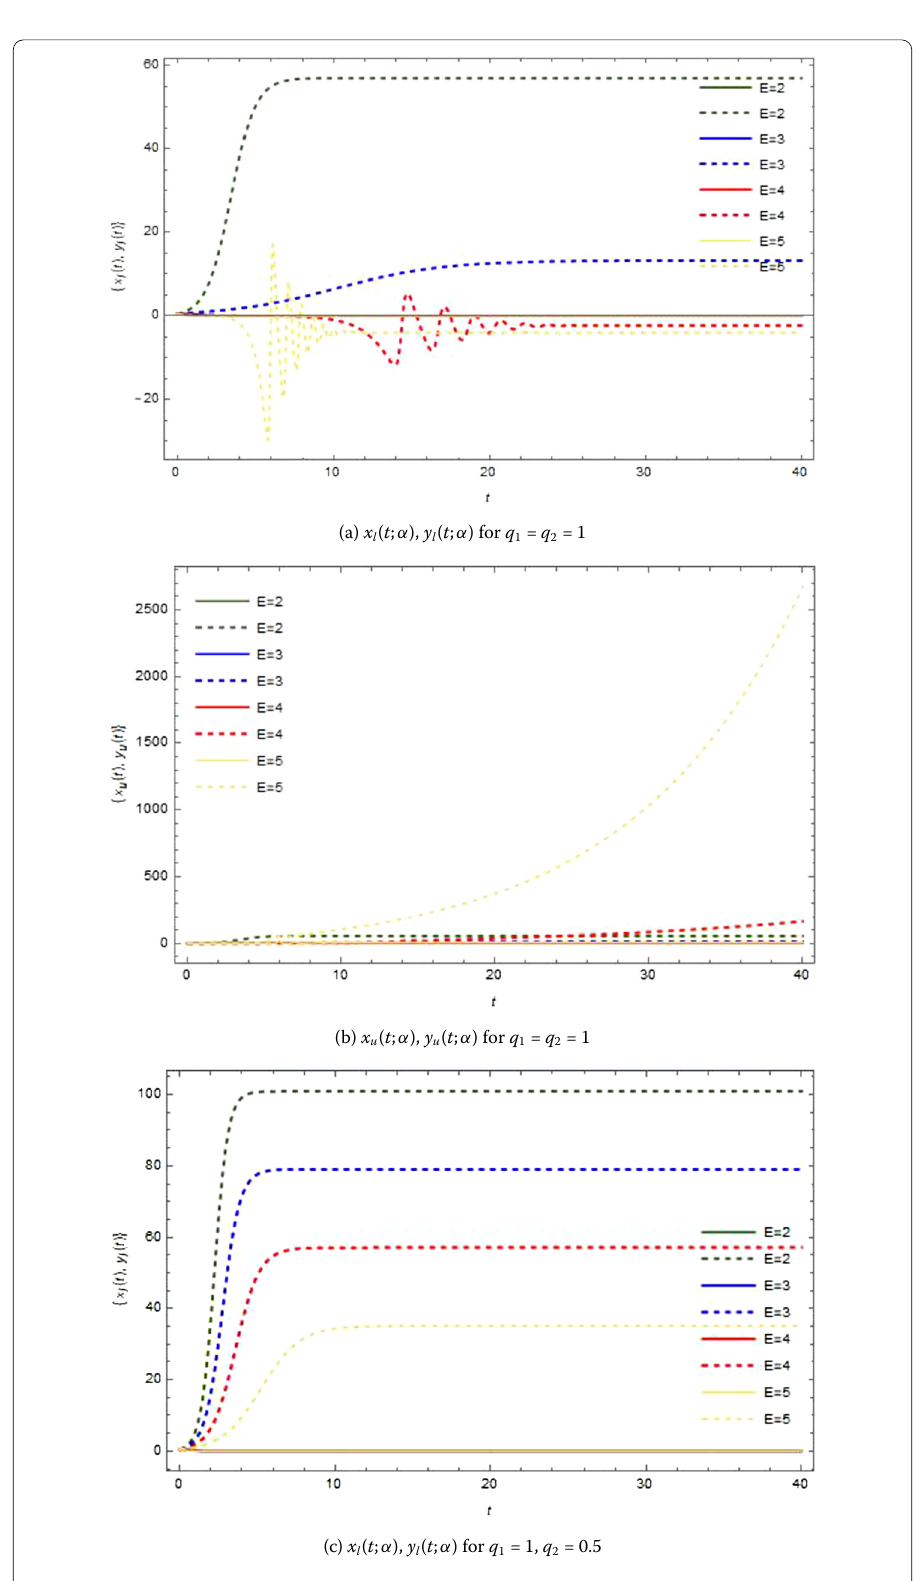
Figure 3 Solutions of system (13), straight lines for ˜ x ( t ) and dotted lines for ˜ y ( t ), for the cases q 1 = q 2 , q 1 > q 2 and q 1 < q 2 at α = 0.98, σ = 0.998 and for different values of